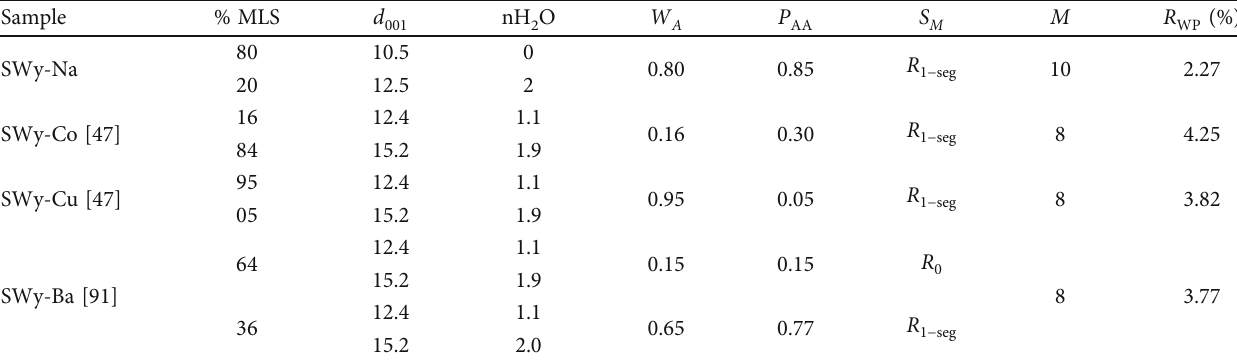
Table 5: Optimum structural parameters used for modeling XRD pro fi les in the case of baseline samples [47, 97].